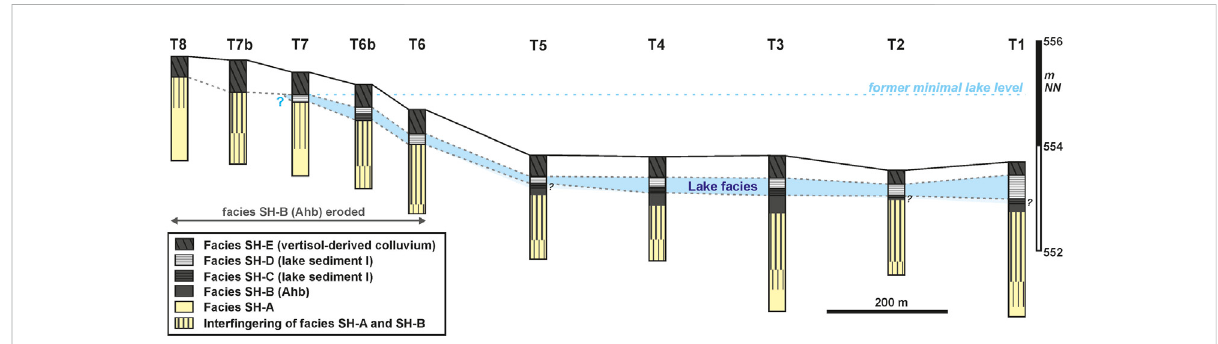
FIGURE 5 StratigraphiesofthedrillingcoresofthetransectinthecentralShirakiPlain(coresT1-T8)withderivedformermaximallakelevelthatwasbased on the occurrence of lake sediments. However, given that lake sediments must have been deposited below a water column of unknown depth, the real maximal lake level must have been somewhat higher than shown